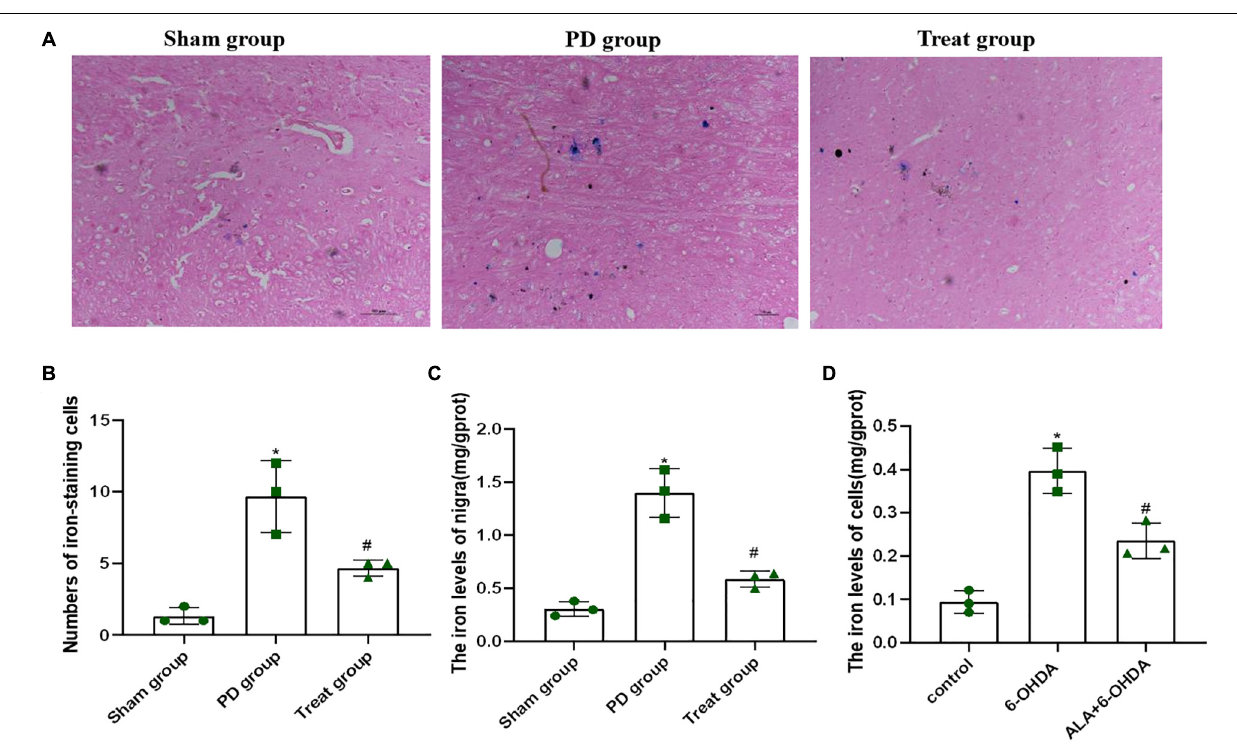
FIGURE 5 | ALA suppresses the 6-OHDA-induced excessive iron accumulation in the SN of rats and PC12 cells. (A) Iron-staining cells in the SN of rats. (B) Corresponding numbers of iron-staining cells in the SN of rats. (C) The total iron content in the SN of rats was detected by using a tissue iron assay kit. (D) The total iron content of PC12 cells was detected by using a tissue iron assay kit. Data were expressed as the means ± SD analyzed by one-way ANOVA ( n = 3). Statistical significance: * P < 0.01 vs. sham group or control; # P < 0.01 vs. PD group or